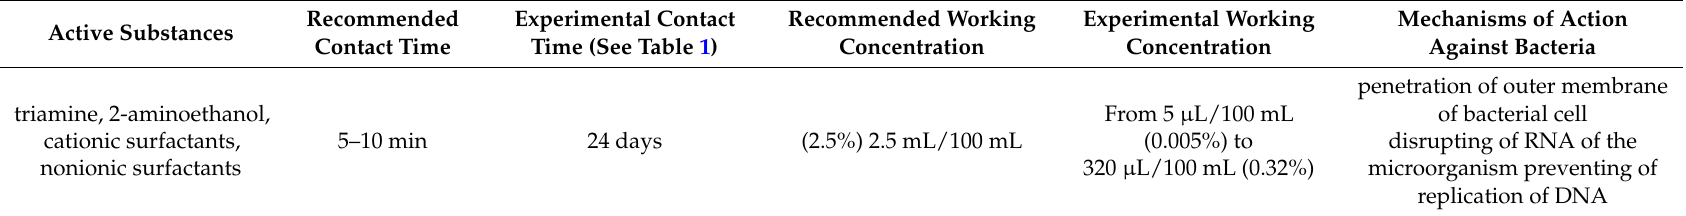
Table 5. Veterinary industry and healthcare environment biocide formulations used in this study (according to the manufacturers’